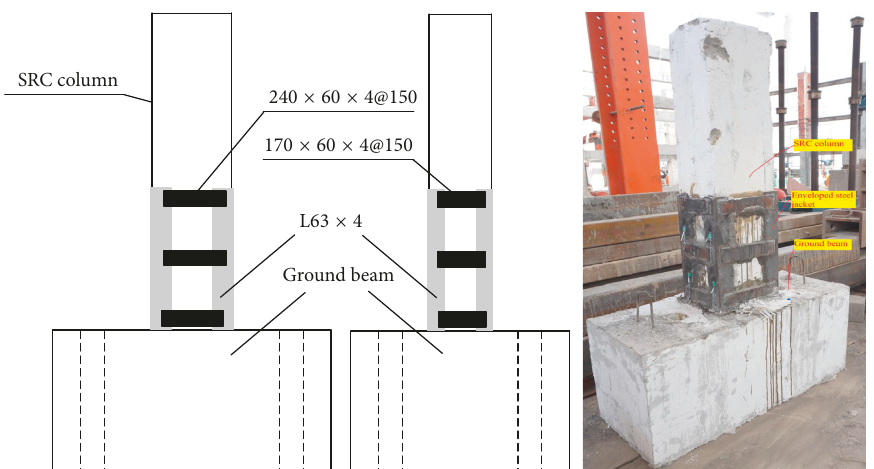
Figure 1: Enveloped steel jacket confined at column bottom.